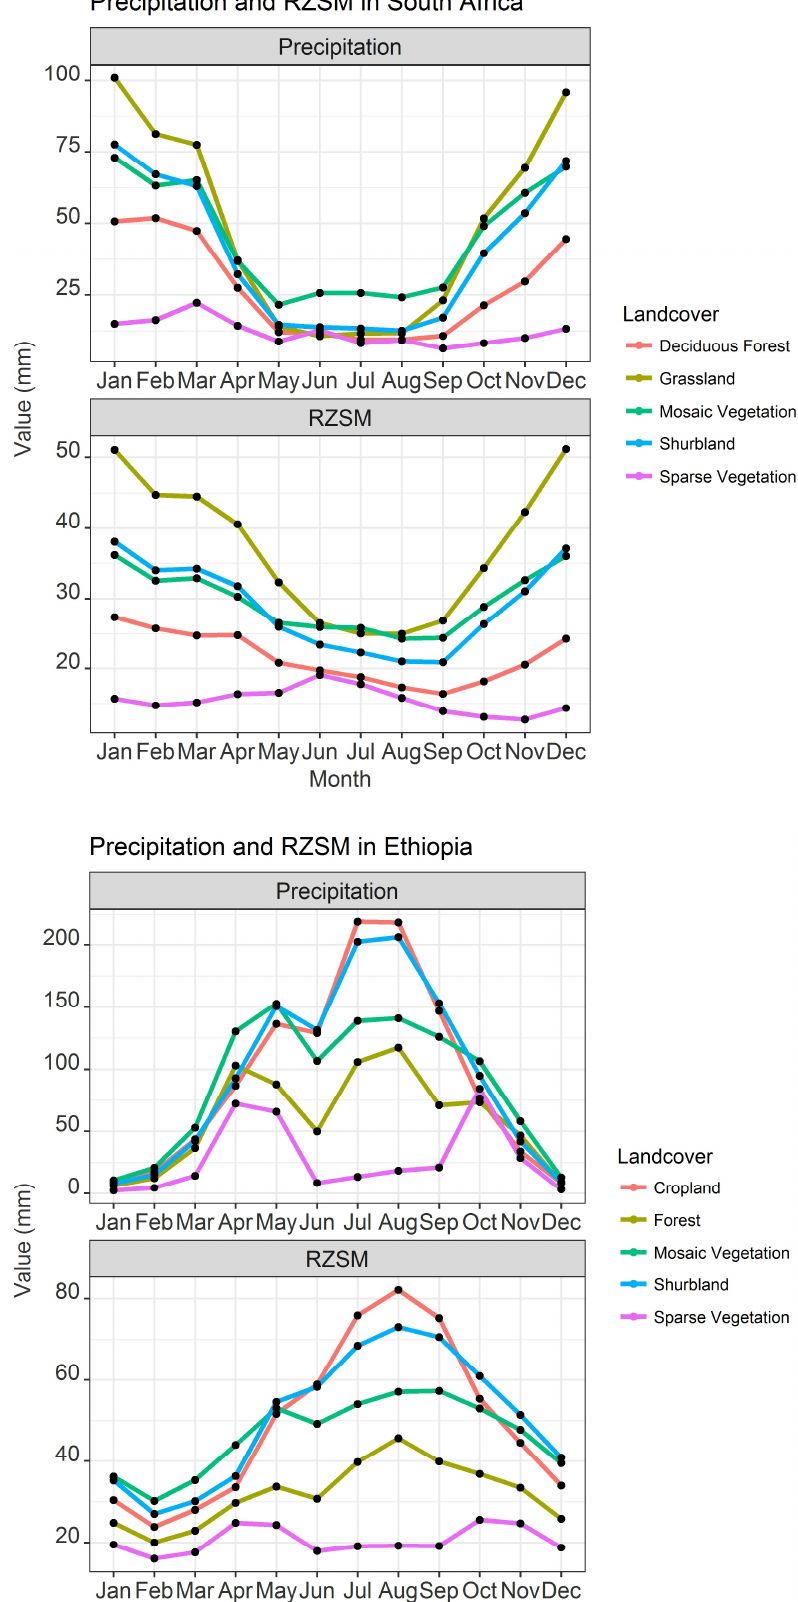
10. Figure 8. Monthly variation of soil moisture and rainfall for different land cover types over South Africa ( top ) and Ethiopia ( bottom